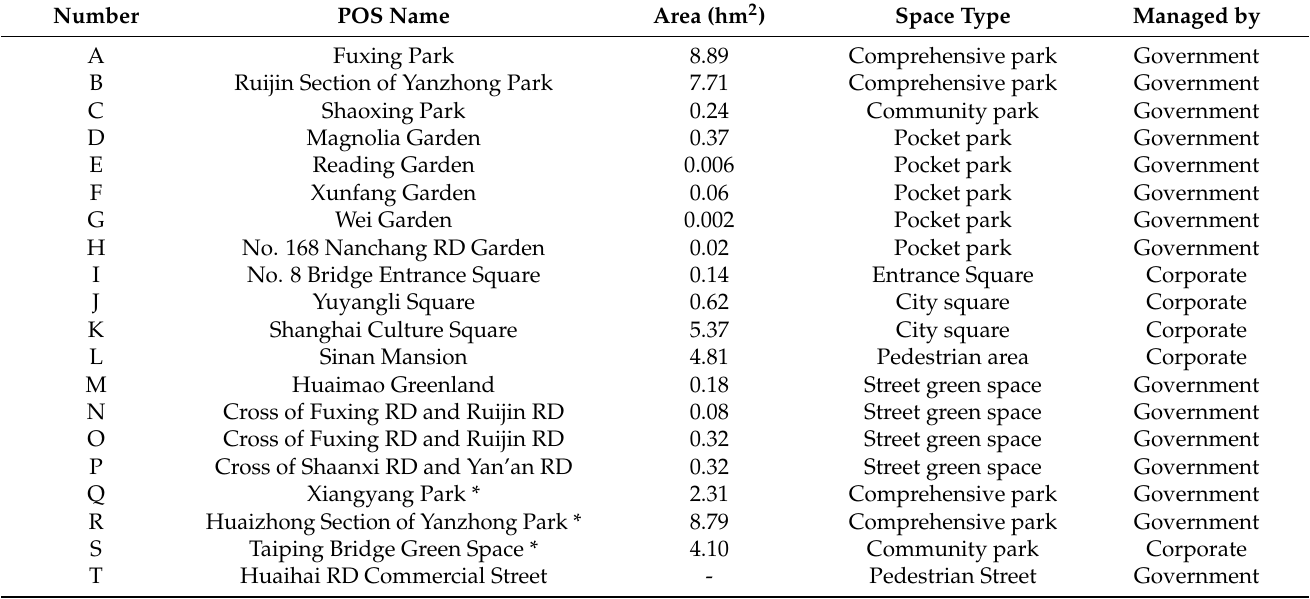
Table 1. Information of the Ruijin community